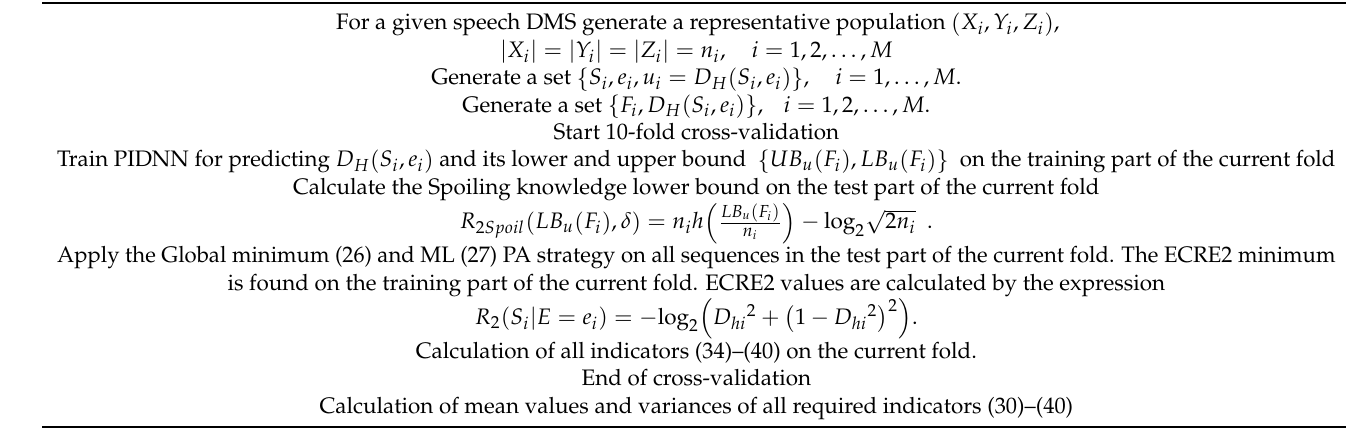
Table 1. Flow chart of experimental